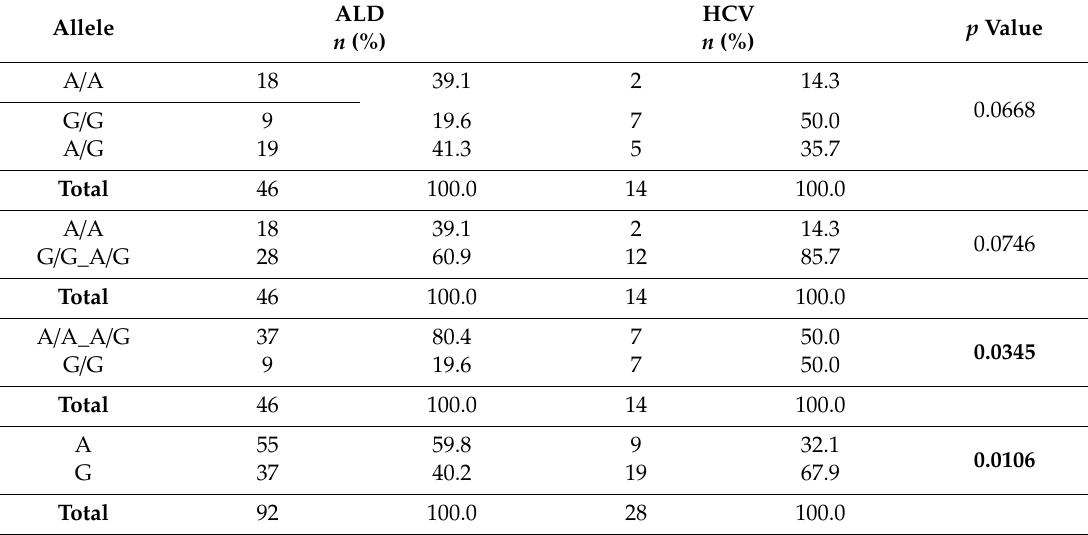
Table 2. Allele Frequencies Compared to Alcoholic liver disease (ALD) / hepatitis C virus (HCV) Groups—SNP rs35652124 (-214 A >